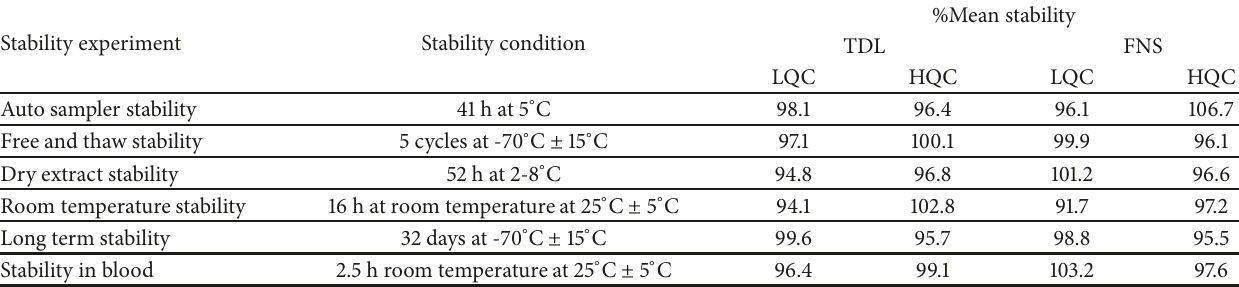
Table 6: Stability results of TMD and